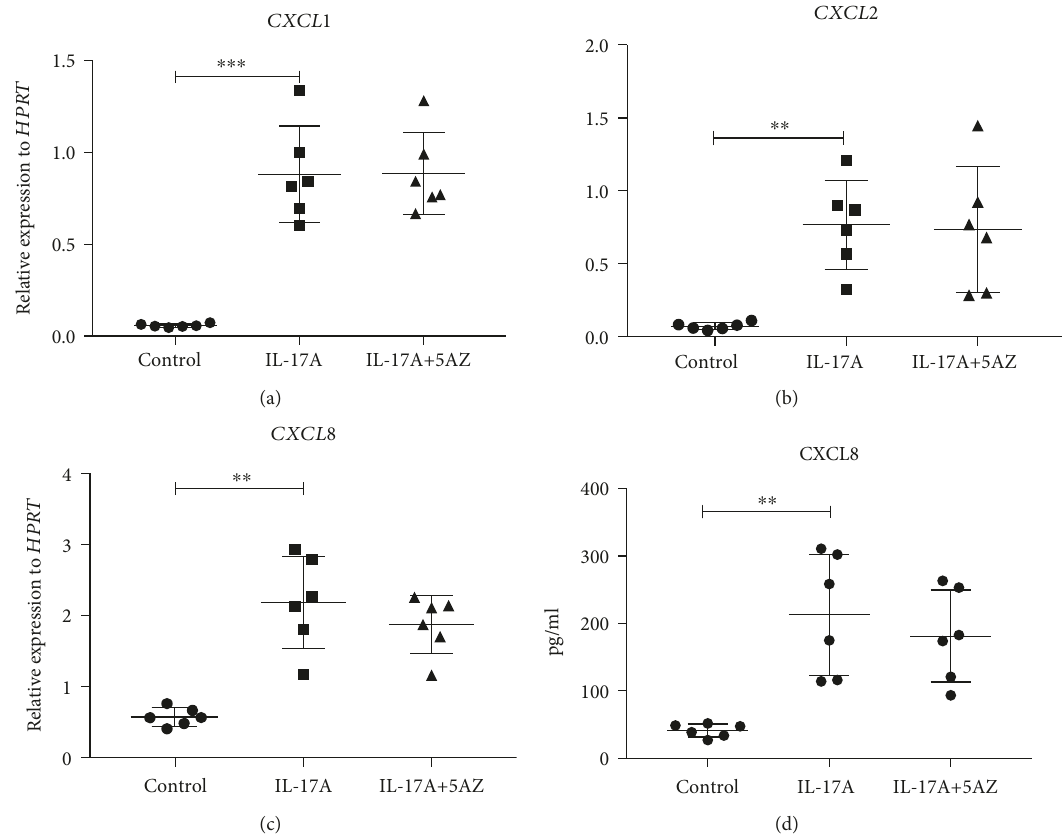
Figure 5: DNA methyltransferase inhibition in HBE1 cells. HBE1 cells were plated 0.08-0.15 million cells per well in a 12-well plate. After incubating with BronchiaLife ™ Epithelial Airway Medium overnight, cells were treated with control medium, 100 ng/ml h-IL-17A protein, 1 μ M 5-azacytidine, and 100ng/ml h-IL-17A plus 1 μ M 5-azacytidine, respectively. 6h after stimulation, chemokine production (a) CXCL1 , (b) CXCL2 , and (c) CXCL8 was determined by RT-PCR. (d) 24h supernatant was collected, and CXCL8 protein level was obtained by ELISA. ∗ p < 0 05 ; ∗∗ p < 0 01 ; ∗∗∗ p < 0 001 ; by paired t -test, two-tailed. This experiment has been